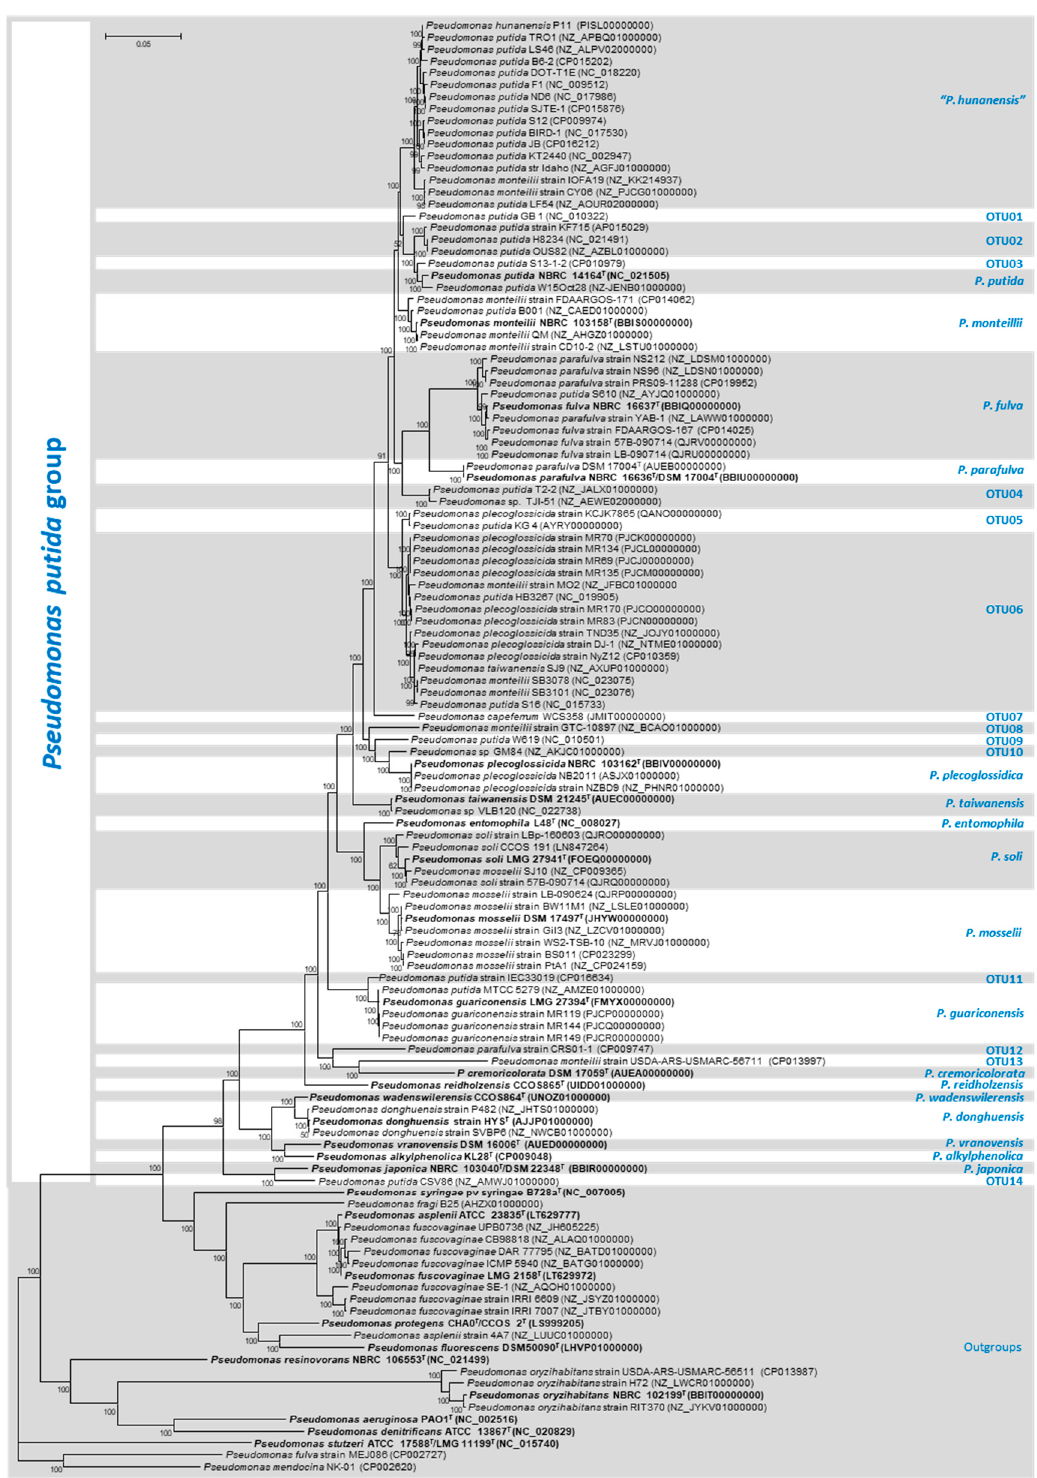
Figure 1. Core genome phylogeny with 123 Pseudomonas genomes, build out of a core of 471 genes per genome (131 ′ 448 amino acid residues per genome) as calculated by EDGAR version 2.2 [19]. Names in the graphic are directly derived from the NCBI database (with accession numbers). Type strains are indicated in bold. The taxonomic speciation in the P. putida group based on ANIb is indicated by the use of different backgrounds.